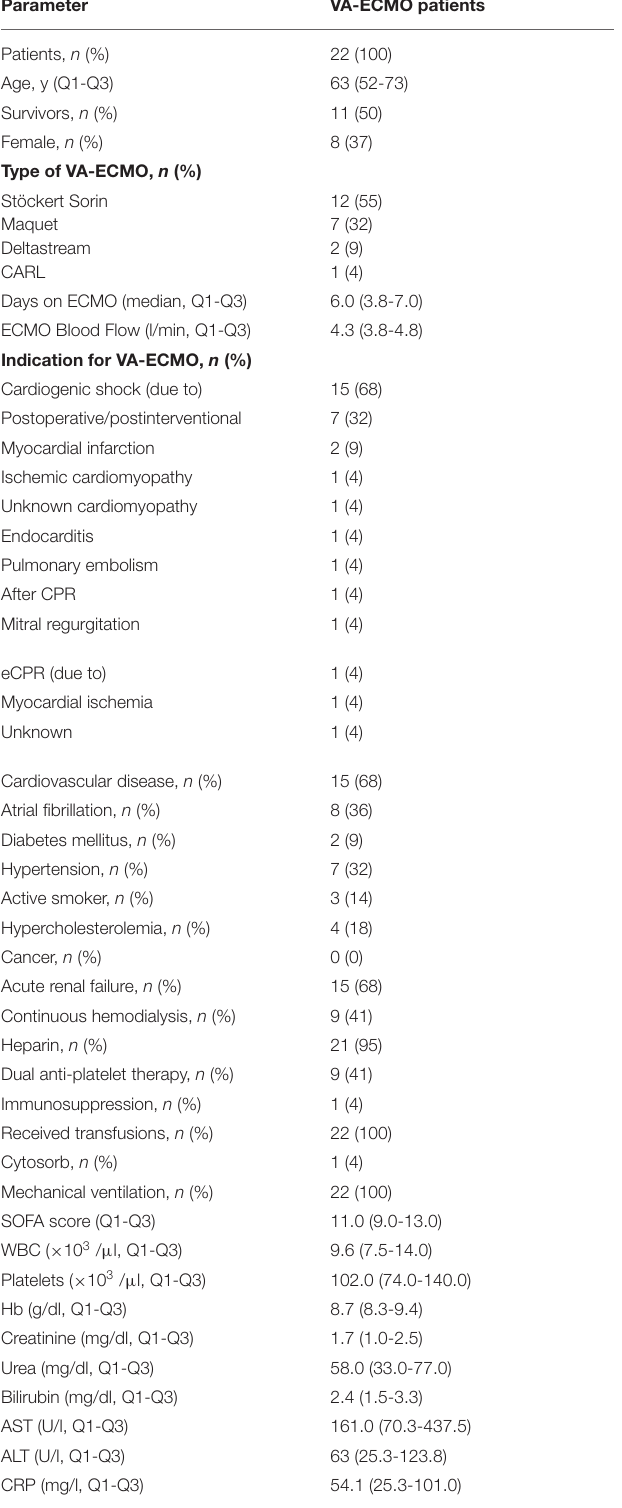
± 3.6, p < 0.001), whereas stimulability was not significantly different (e.g., percentage binding VA-ECMO day 0 vs.